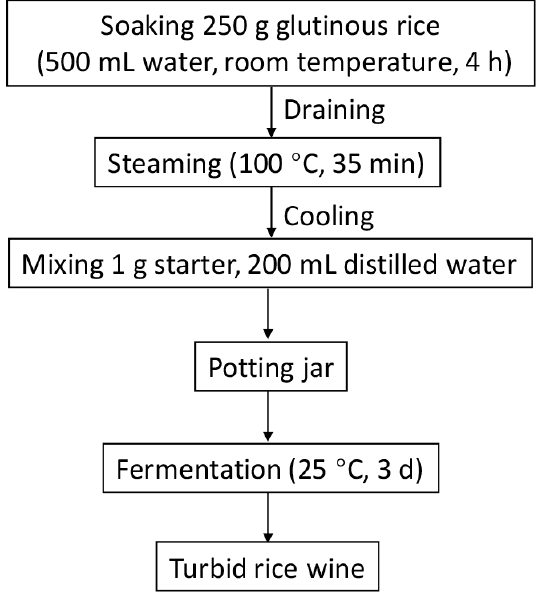
Figure 2. Schematic diagram of turbid rice wine fermentation.